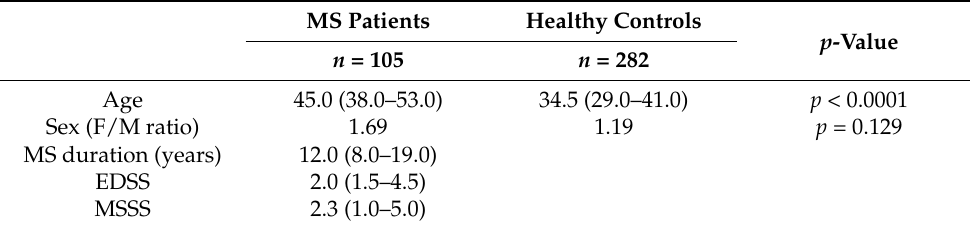
Table 1. Demographic and clinical characteristics of the examined MS patients and healthy controls. Data are expressed as number of subjects or median (95% CI). The two-sample Wilcoxon rank-sum (Mann–Whitney) test and the χ 2 test were used to compare age and sex in MS cases and healthy con- trols, respectively. p < 0.05 was considered statistically significant. Abbreviations: EDSS = expanded disability status scale; F/M = female to male ratio. MS = multiple sclerosis; MSSS = multiple sclerosis severity score.